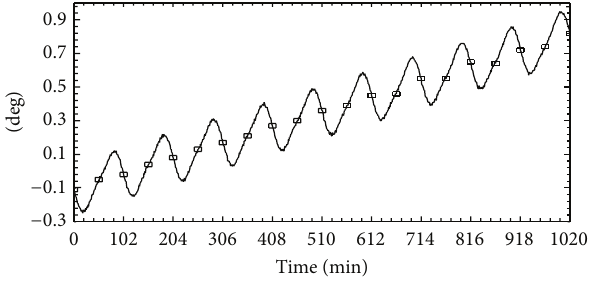
Figure 4: Difference in argument of latitude.